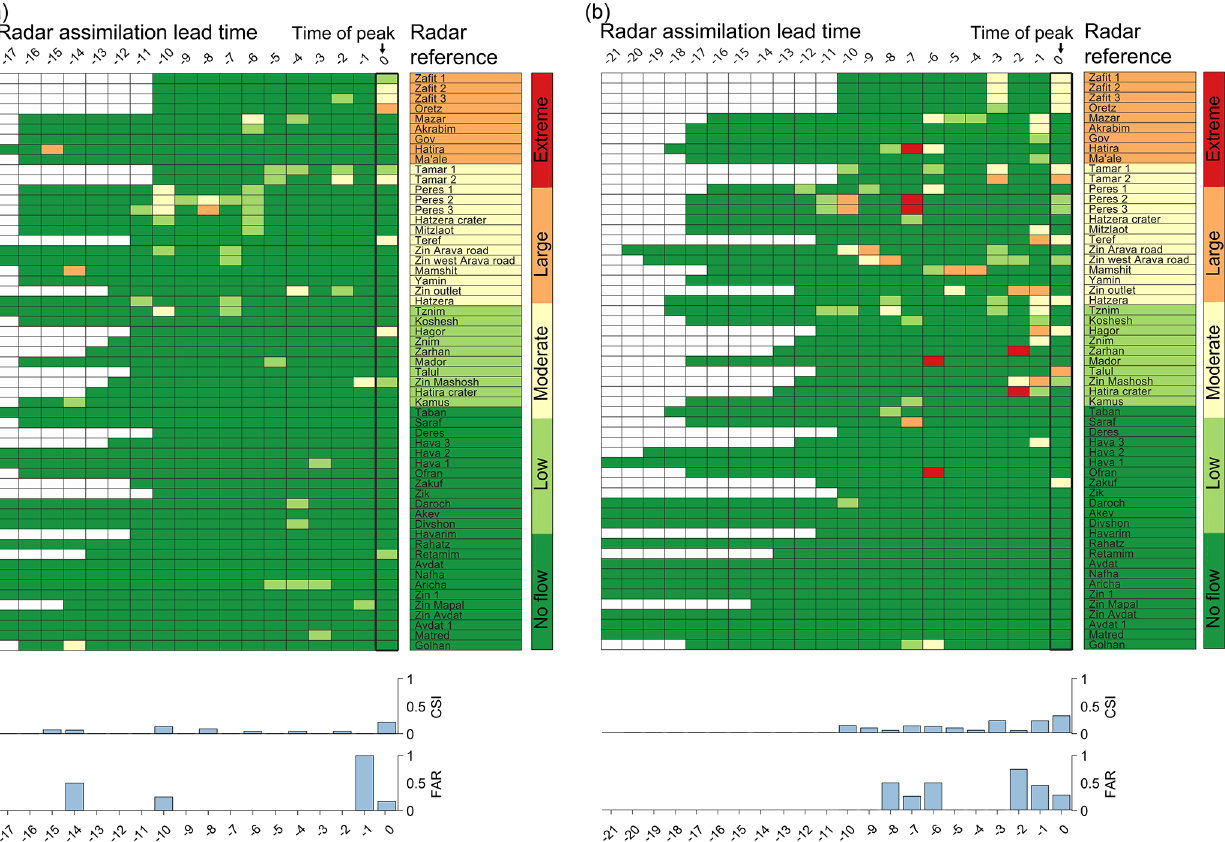
Figure 11. Flash-flood return period categories calculated for each subbasin using the 25 April, 19:30 (a) , and 26 April, 09:30 (b) , COSMO runs with different radar assimilation lead times. Numbers represent the time in hours prior to the 26 April peak discharge at each subbasin, i.e., the lead time (where 0 is the hour of the peak, columns are not synchronal). Radar reference, CSI, and FAR metrics are